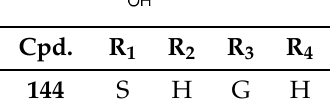
Figure 11. Structure of compound 144 . Molecules 2016 , 21 , 1402